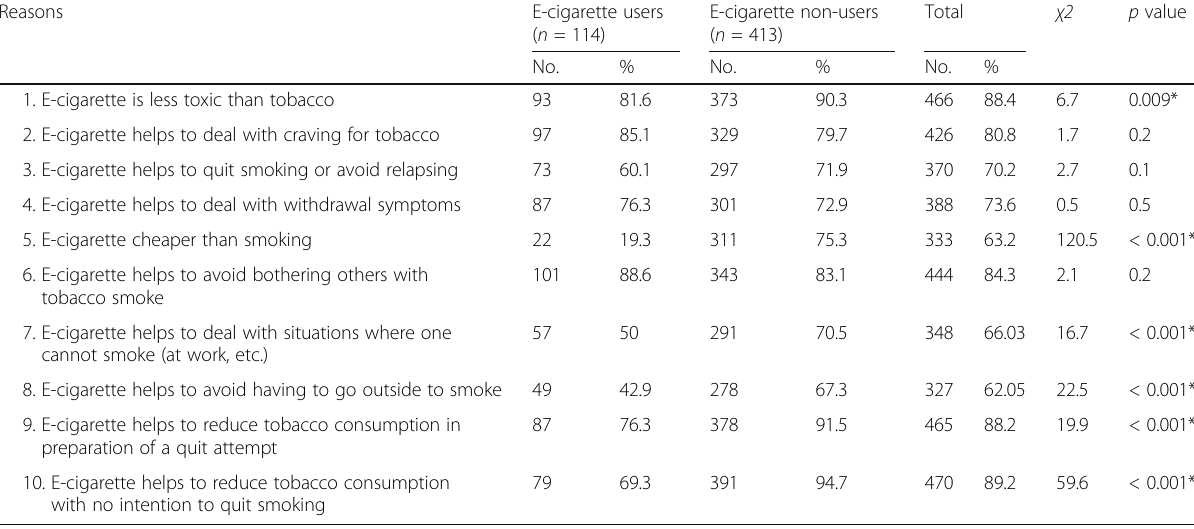
Table 2 Reasons for using E-cigarette among surveyed students, Taibah University, KSA ( n = 527) Reasons